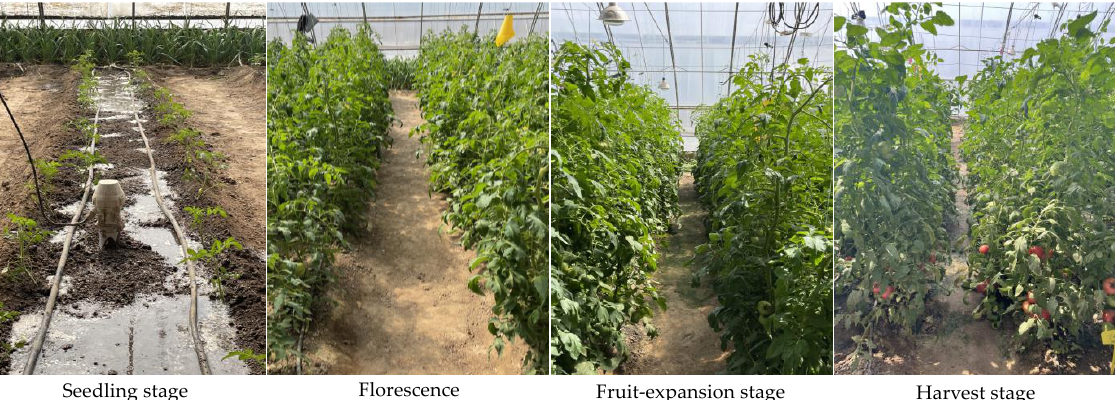
Figure 2. Tomato growth stages.